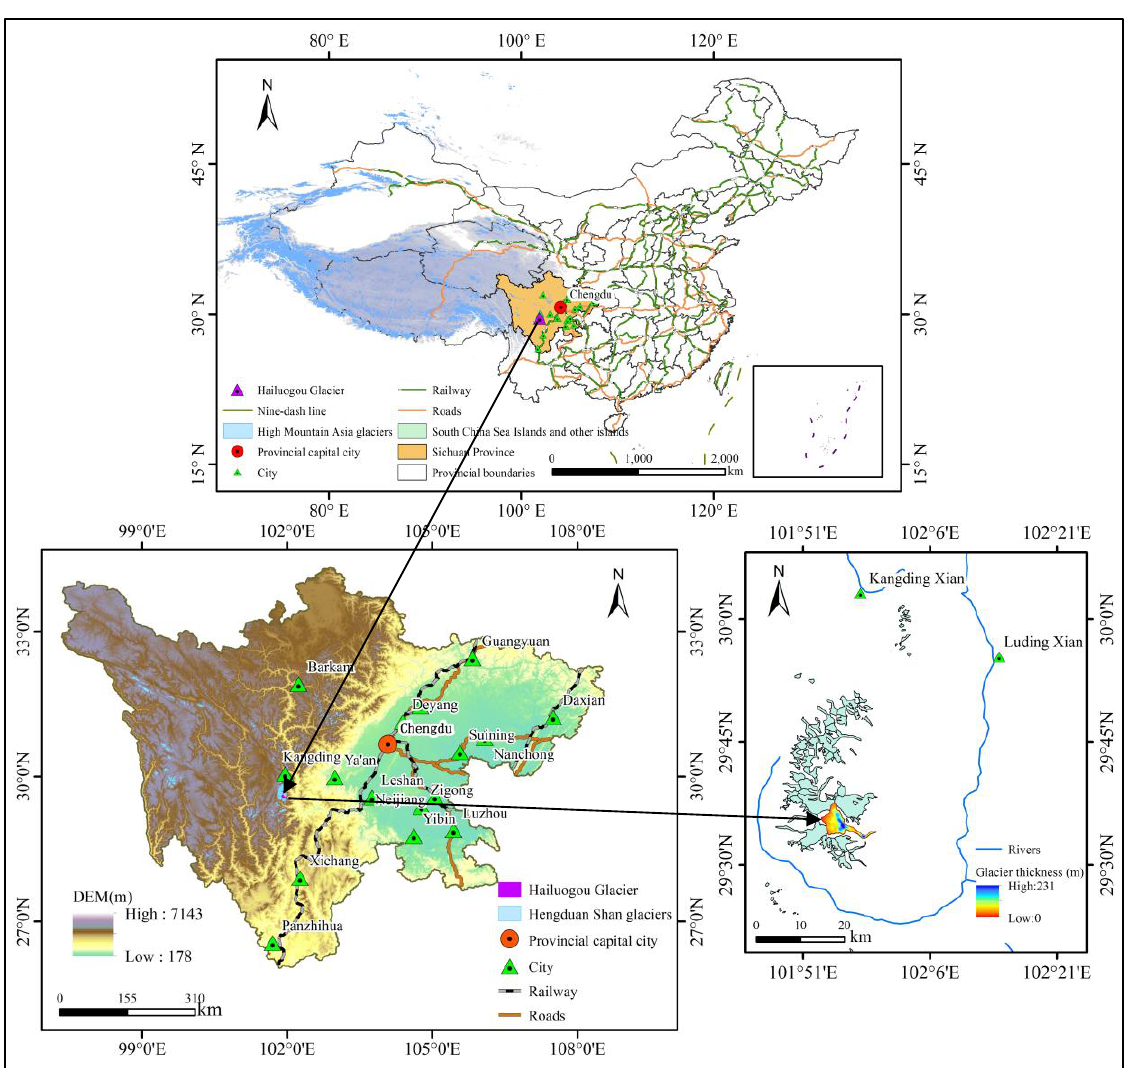
Figure 2 After modification “ Location map of Hailuogou Glacier Forest Park ” . Figure 1. Location map of Hailuogou Glacier Forest